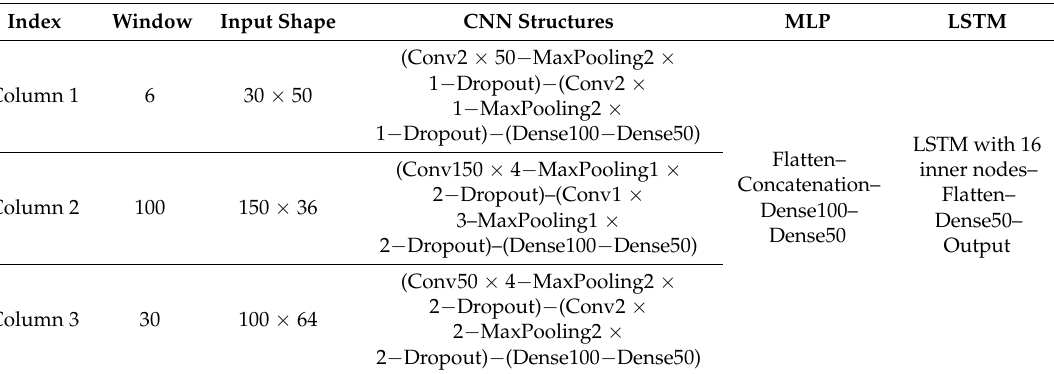
Table 2. Detailed network structure.